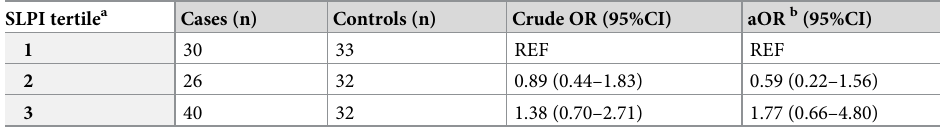
Table 3. Association between oral SLPI with risk of